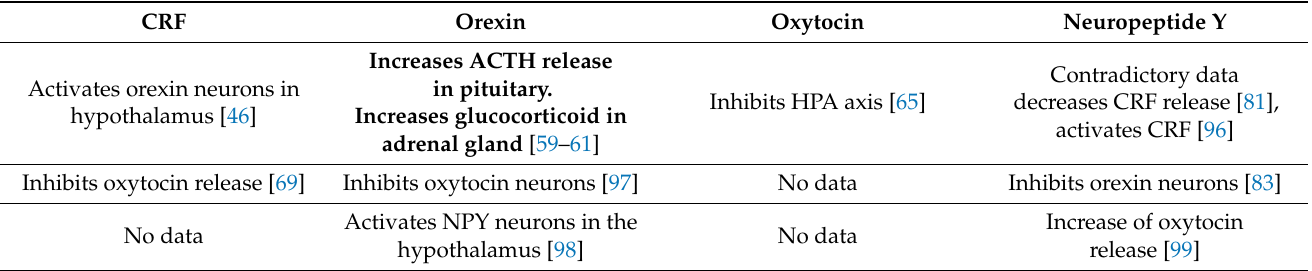
Table 2. Interaction between hypothalamic